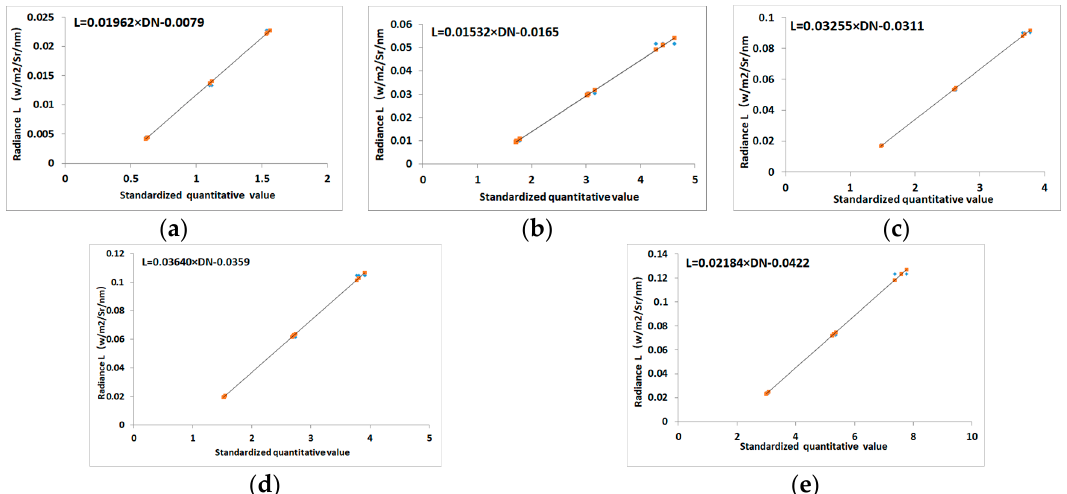
Figure 16. Linear fitting results for different bands: ( a ) Band1; ( b ) Band2; ( c ) Band3; ( d ) Band4; ( e ) Band5. Table 2. Coefficient a, offset b, R-square, RMSE, and MS of residual of linear fitting.